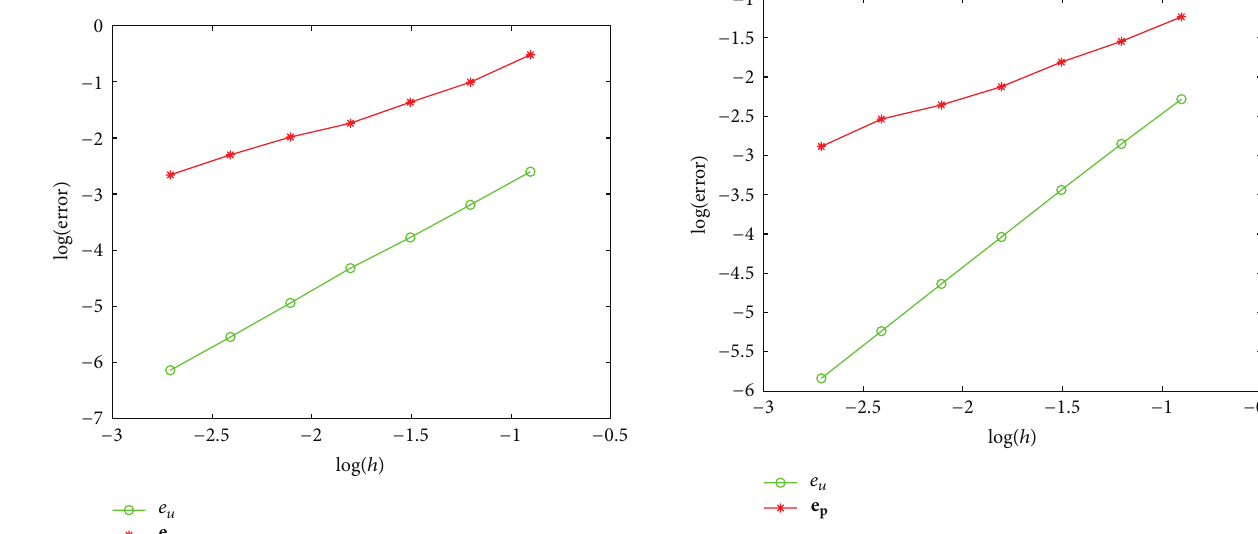
Figure 6: The convergence rates of 𝐿 2 norm in the exact 𝑢 and its flux p for 𝛽 1 : 𝛽 2 = 1000: